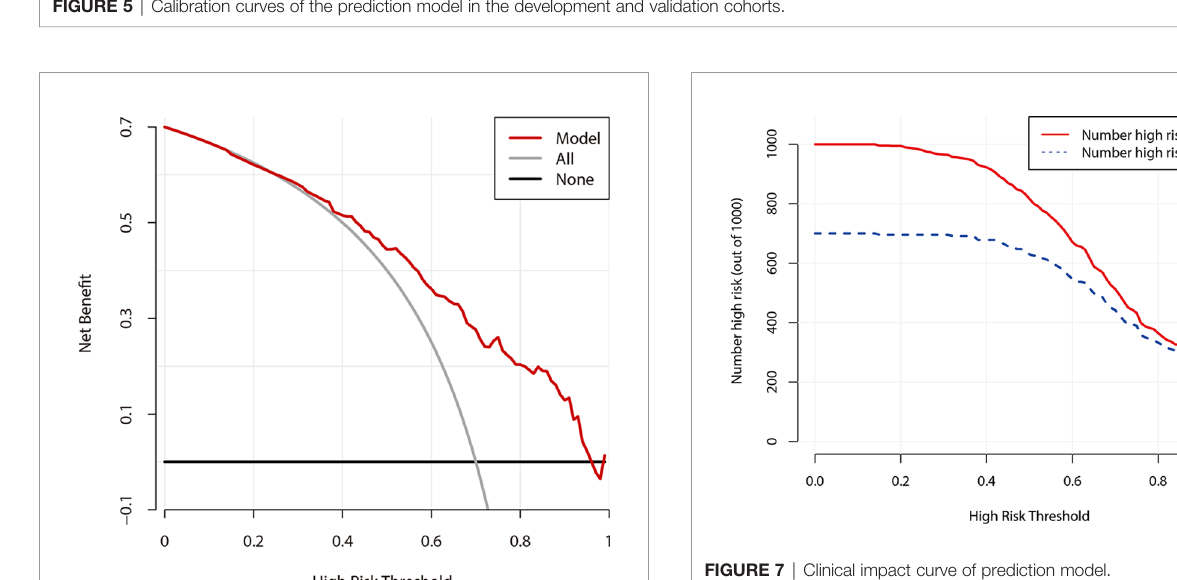
FIGURE 5 | Calibration curves of the prediction model in the development and validation cohorts.